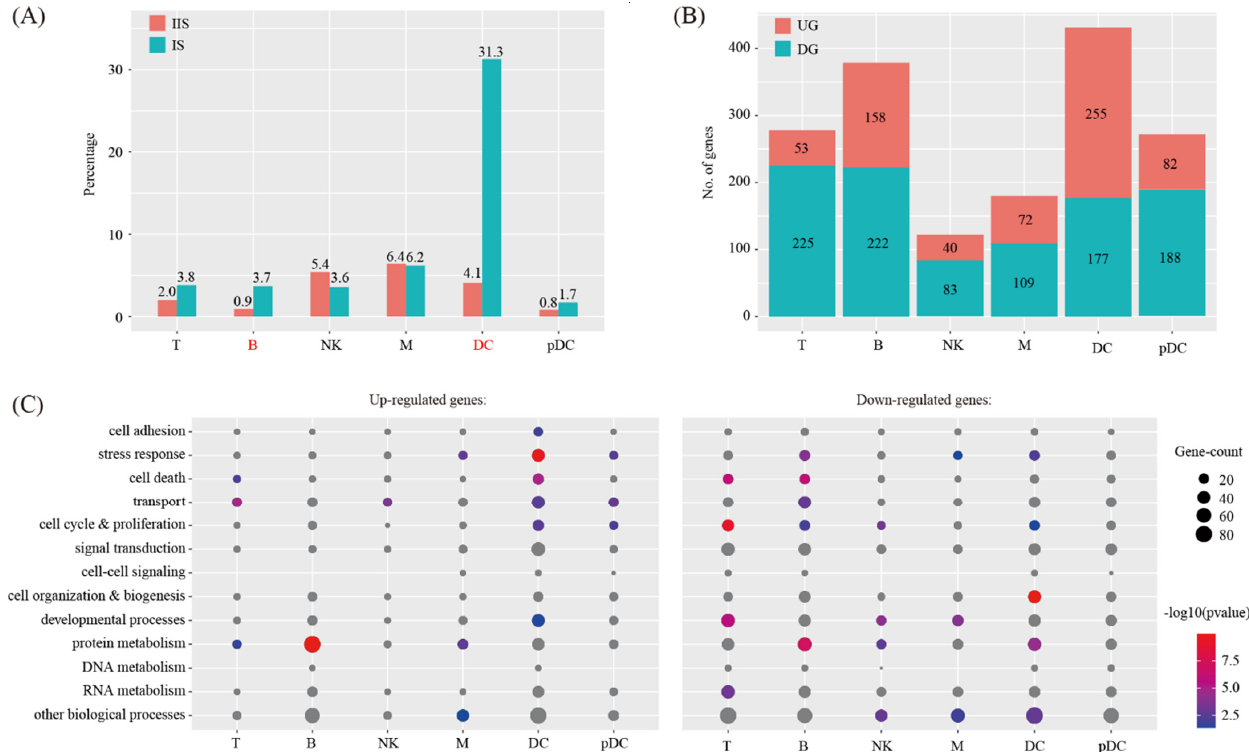
Figure 4. Identification of differentially expressed genes in immune cells upon decidualization. ( A ) Bar plot showing the cell population change of 6 major immune cell types at IS compared to IIS. Cell types with FC > 2 and p < 0.05 using χ 2 test were labeled in red. ( B ) Bar plot showing the count of differentially expressed genes in each immune cell type. The threshold values for differentially expressed genes were logFC > 0.25 and p < 0.05. UG, up-regulated gene; DG, down-regulated genes. ( C ) Gene ontology (GO) enrichment analysis of differentially expressed genes. Differentially expressed genes were grouped based on MGI GOslim terms under the biological process categories. Up-regulated genes and down-regulated genes were tested separately. Abbreviations for cell types are listed in Figure 2.